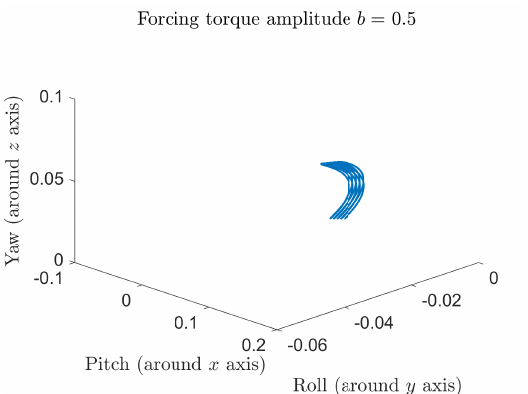
( a ) Entries of the attitude matrix R over time. ( b ) Pitch, roll and yaw angles parametrized by time.